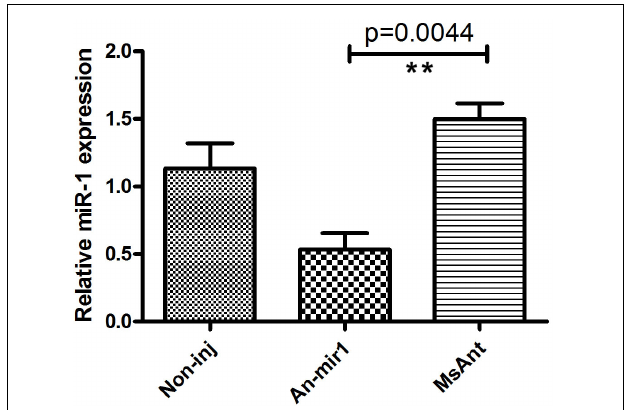
FIGURE 9 | Relative mature miR-1 expression in fed female ticks treated with the miR-1 antagomir. Data represent three biological replicates with three technical replicates and are shown as the mean ± SEM. ∗∗ P = 0.0044 < 0.01 (Student’s t -test).